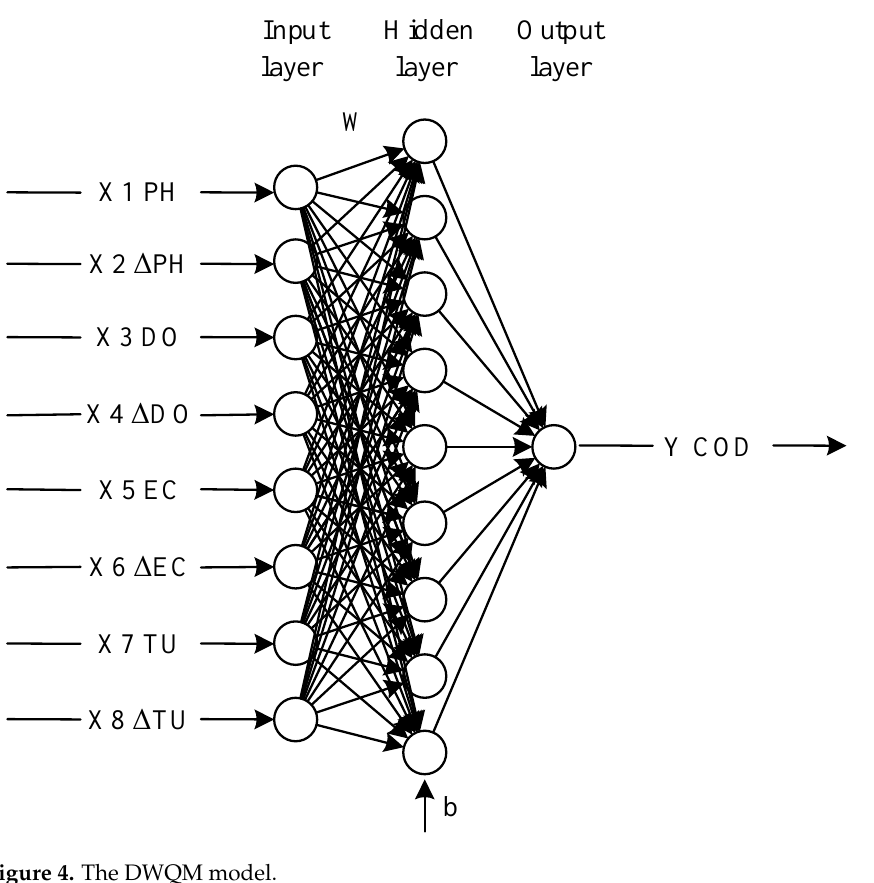
Figure 4. The DWQM model.